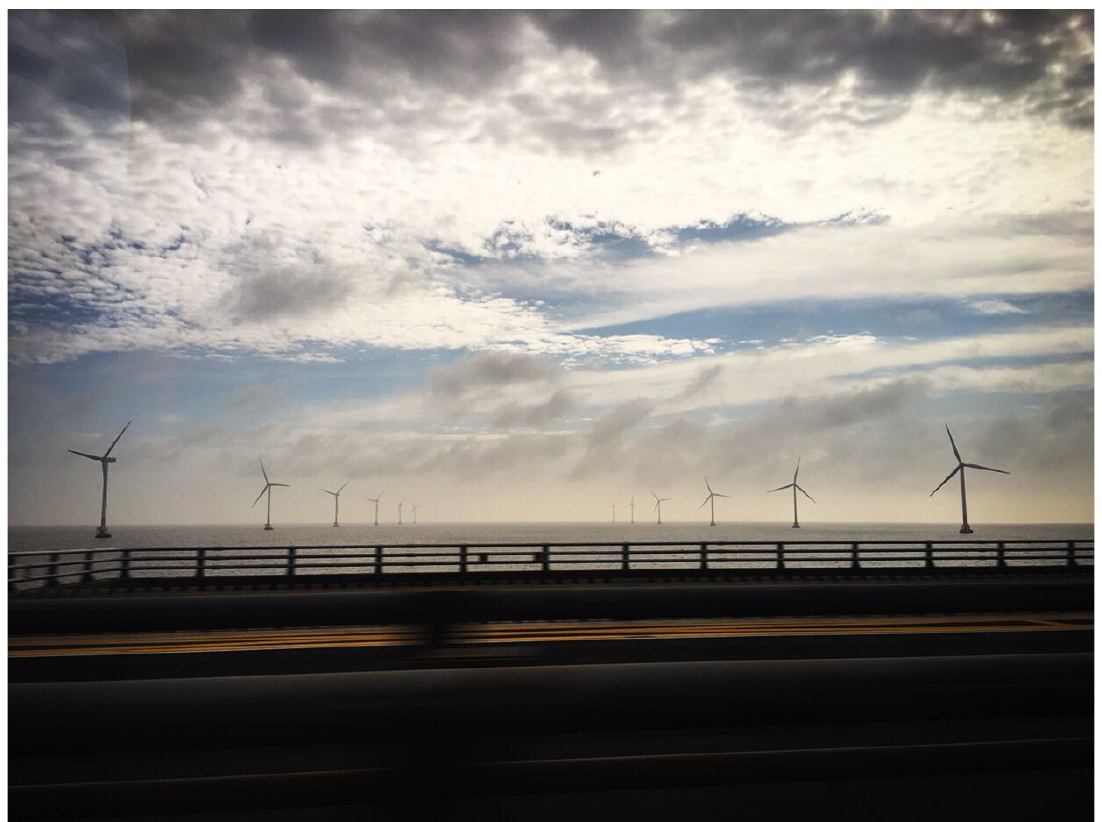
Figure 2. Off-shore wind farm of Yangshan Deepwater Harbor in the Port of Shanghai,